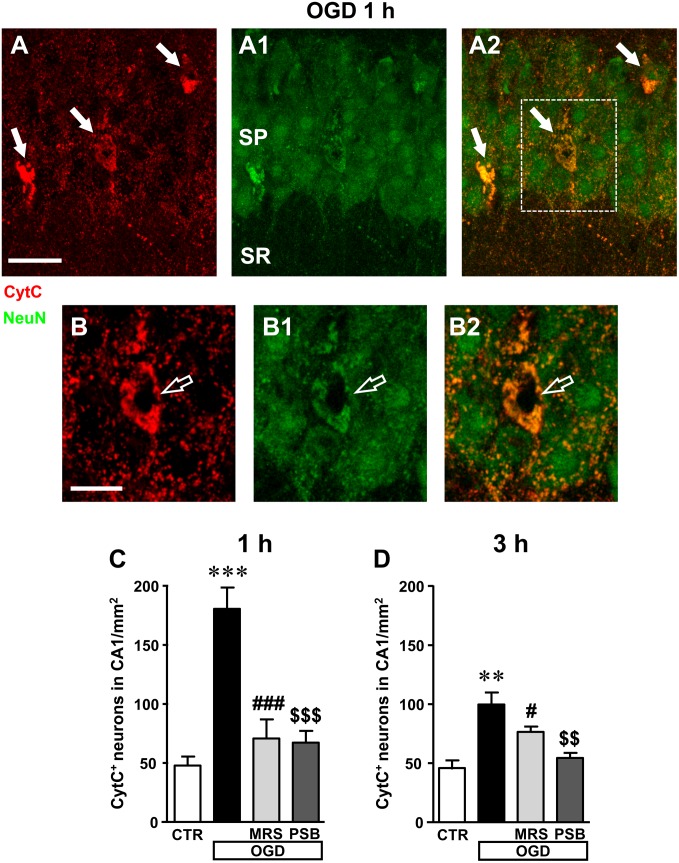
Analysis of CytocromeC+ (CytC+) neurons in CA1 stratum pyramidale after the simil-ischemic insult. (A–A2) Representative microphotographs, taken at the laser scanning confocal microscope, of apoptotic neurons labeled with anti-CytC antibody (A, red), of pyramidal neurons labeled with anti-NeuN antibody (A1, green) and the merge of the two previous images (A2). NeuN+ and CytC+ apoptotic neurons in CA1 stratum pyramidale are indicated by the arrows (yellow-orange color in A2). Scale bar: 25 μm. (B–B2) Subslice of the framed area in A2, obtained stacking 17 consecutive confocal z-scans (5.1 μm total thickness), shown at higher magnification (2×). The open arrow shows an LDN apoptotic pyramidal neuron. Scale bar: 10 μm. (C,D) Quantitative analysis of NeuN+ and CytC+ neurons in CA1 stratum pyramidale at 1 h (C) and 3 h (D) after the end of 7 min OGD. Note the significant increase of CytC+ neurons both 1 and 3 h after the end of OGD. (C) Statistical analysis: One-way ANOVA: F(3;11) = 18.40, P < 0.001, Newman–Keuls multiple comparison test: ∗∗∗P < 0.001, OGD vs. CTR; ###P < 0.001, OGD+MRS vs. OGD; $$$P < 0.001, OGD+PSB vs. OGD. CTR, n = 4; OGD, n = 3; OGD+PSB, n = 4; OGD+MRS, n = 4. (D) Statistical analysis: One-way ANOVA: F(3;11) = 11.41, P < 0.02, Newman–Keuls multiple comparison test: ∗∗P < 0.01, OGD vs. CTR; #P < 0.05, OGD+MRS vs. OGD; $$P < 0.01, OGD+PSB vs. OGD. CTR, n = 4; OGD, n = 3; OGD+PSB, n = 4; OGD+MRS, n = 4. All data in the graphs are expressed as mean ± SEM.